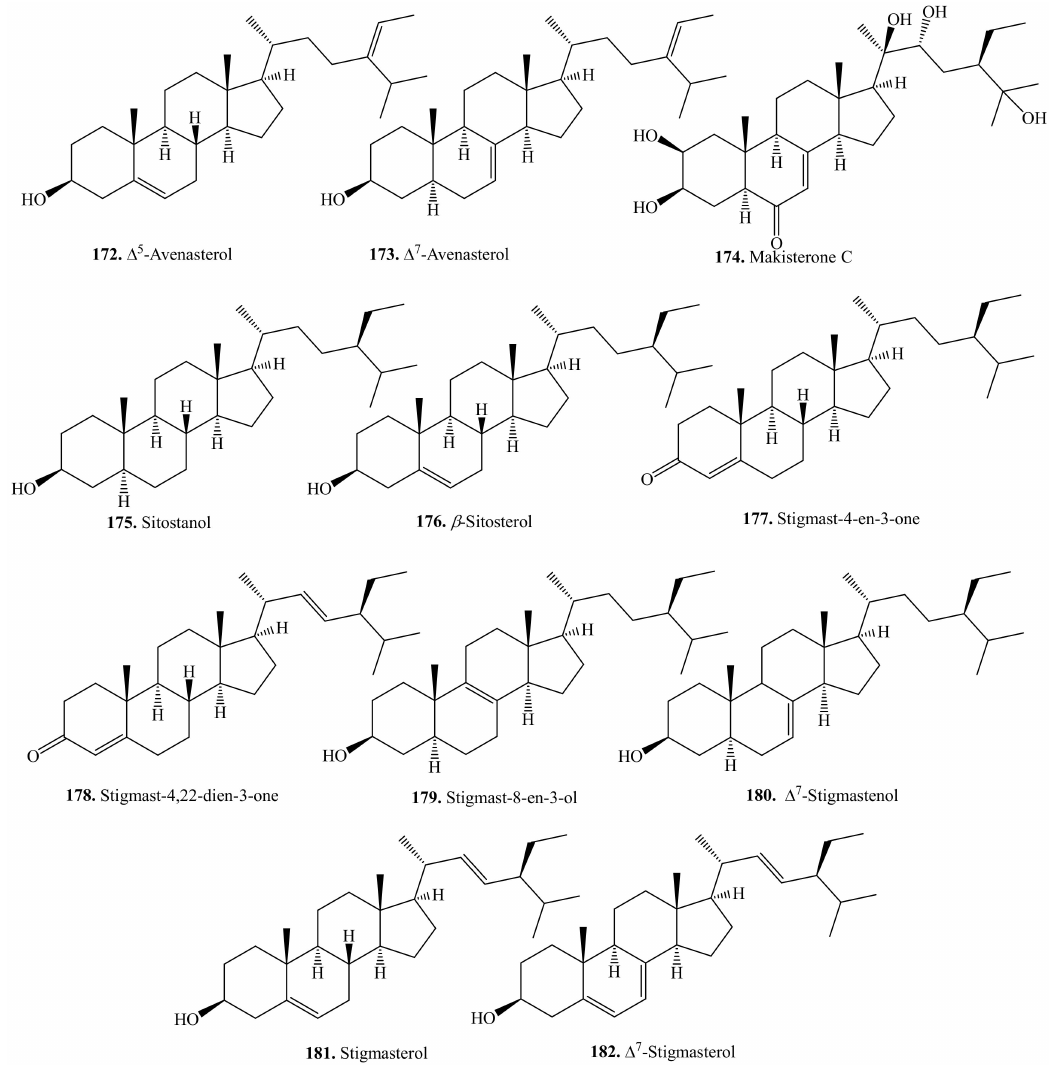
Figure 24. Structures of the C 29 -steroids isolated from